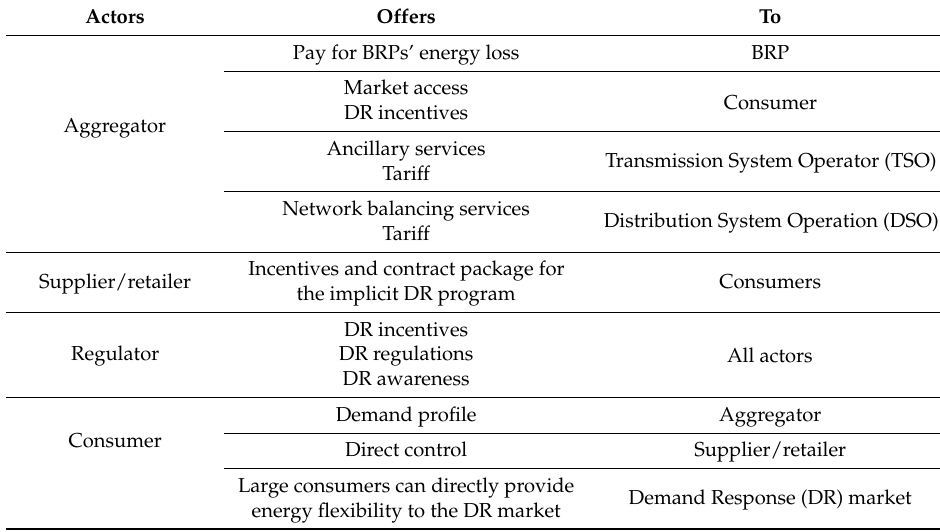
Table 1. Actors in demand